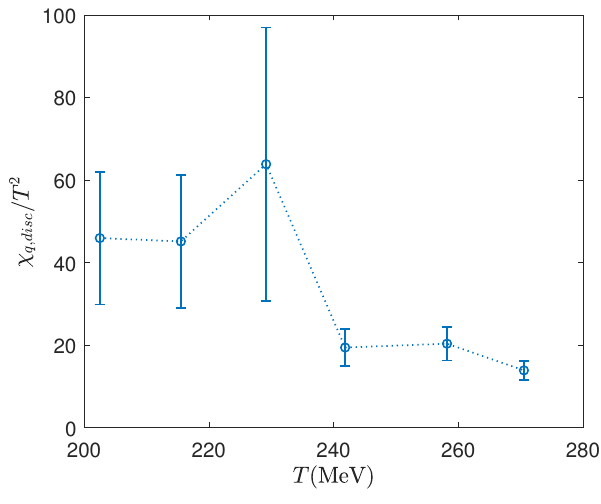
Figure 2 . χ q, disc /T 2 as a function of T